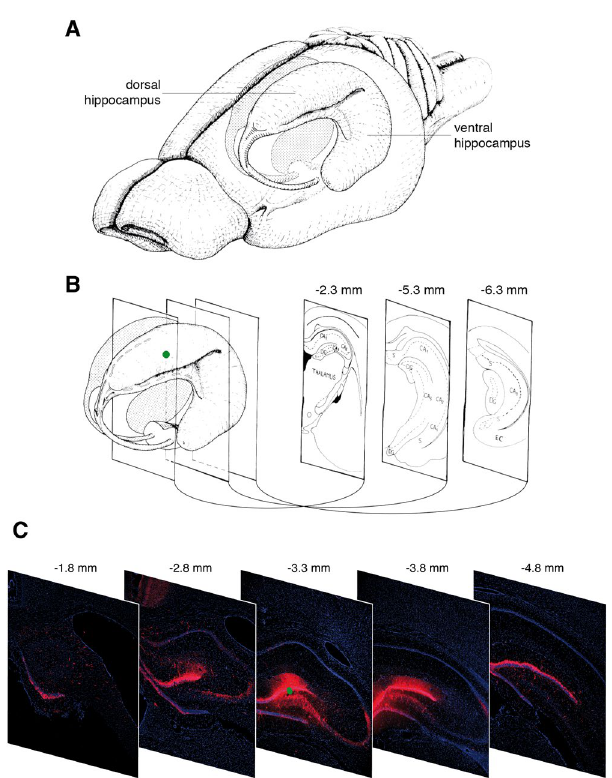
Figure 2. Distribution of cells expressing the mCherry reporter gene. ( A ) Drawing of the rat brain showing the three-dimensional organization of the hippocampus. ( B ) Coronal sections across the hippocampus. Three coronal sections through the hippocampus are shown at the right, including their anteroposterior coordinates relative to bregma. At the left, the green dot indicates the site of J Δ NI6 injection. ( C ) Representative images of coronal sections from animals killed 2 months after J Δ NI6 injection. Five coronal sections through the hippocampus are shown with their anteroposterior coordinates relative to bregma. Native mCherry fluorescence in red; nuclei stained with DAPI in blue. The green dot in the central image indicates the site of J Δ NI6 injection. Panels A and B are adapted from Fig. 1 of Amaral and Witter 23 with permission from